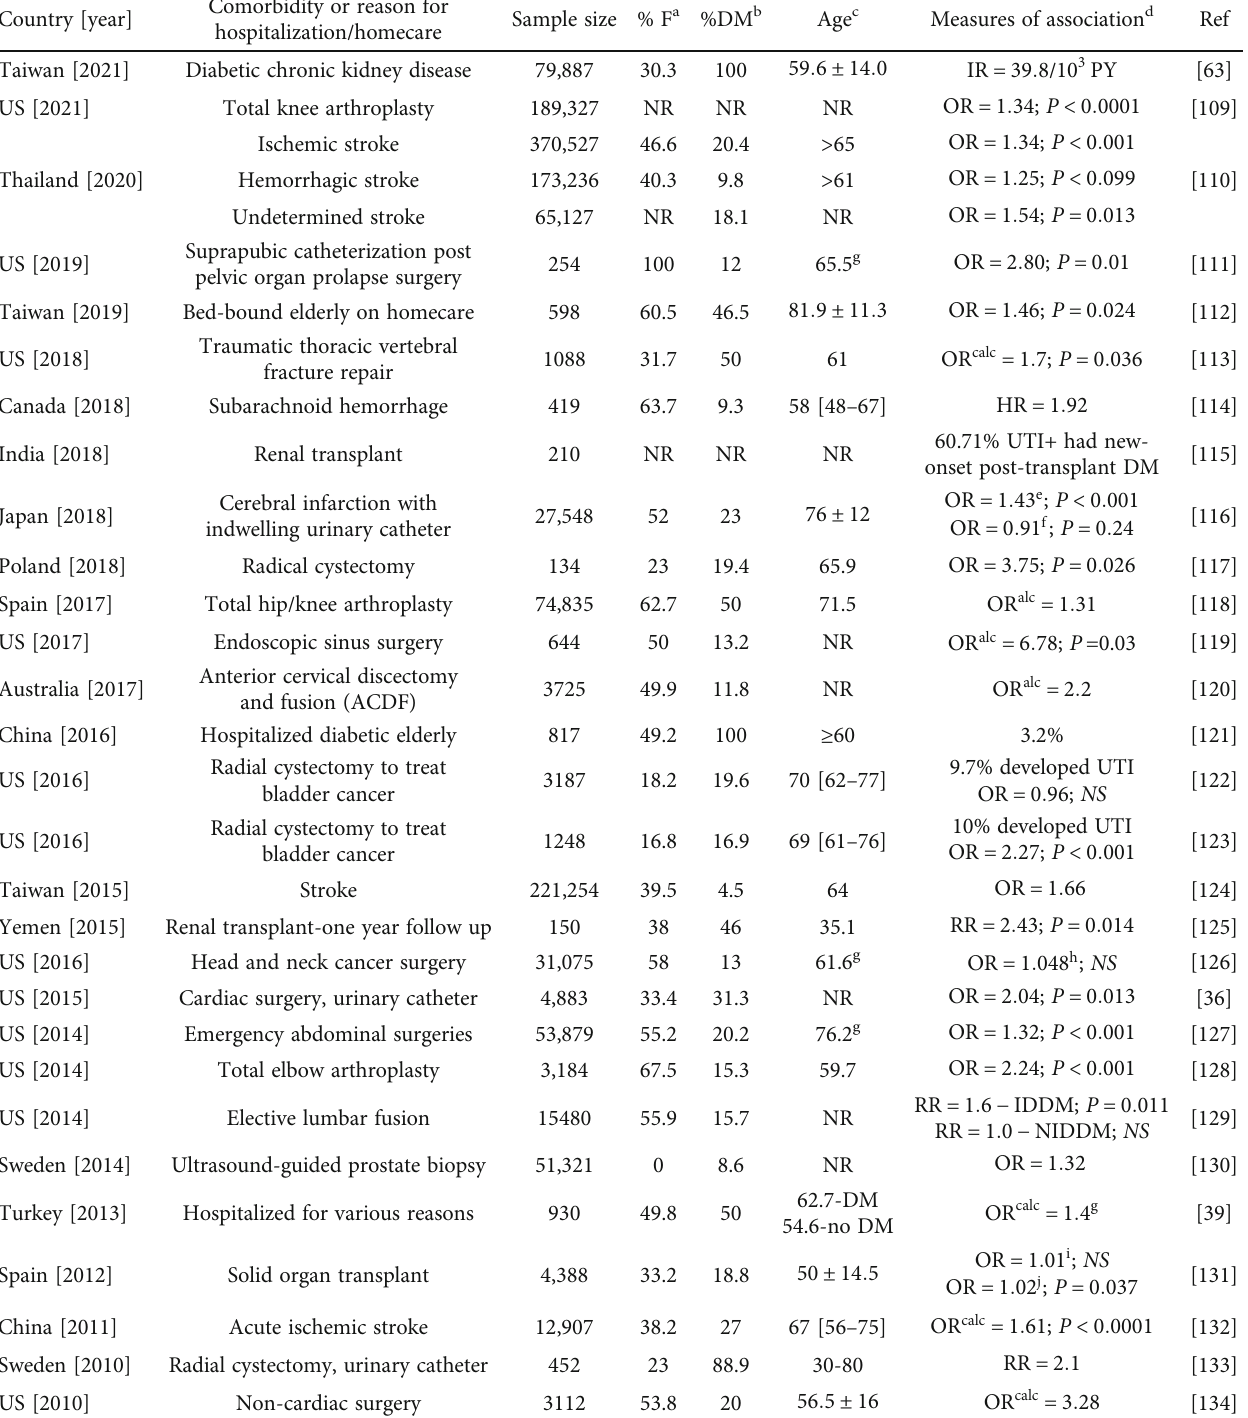
Table 3: Studies examining incidence and prevalence of healthcare-associated UTI in diabetic individuals. Country